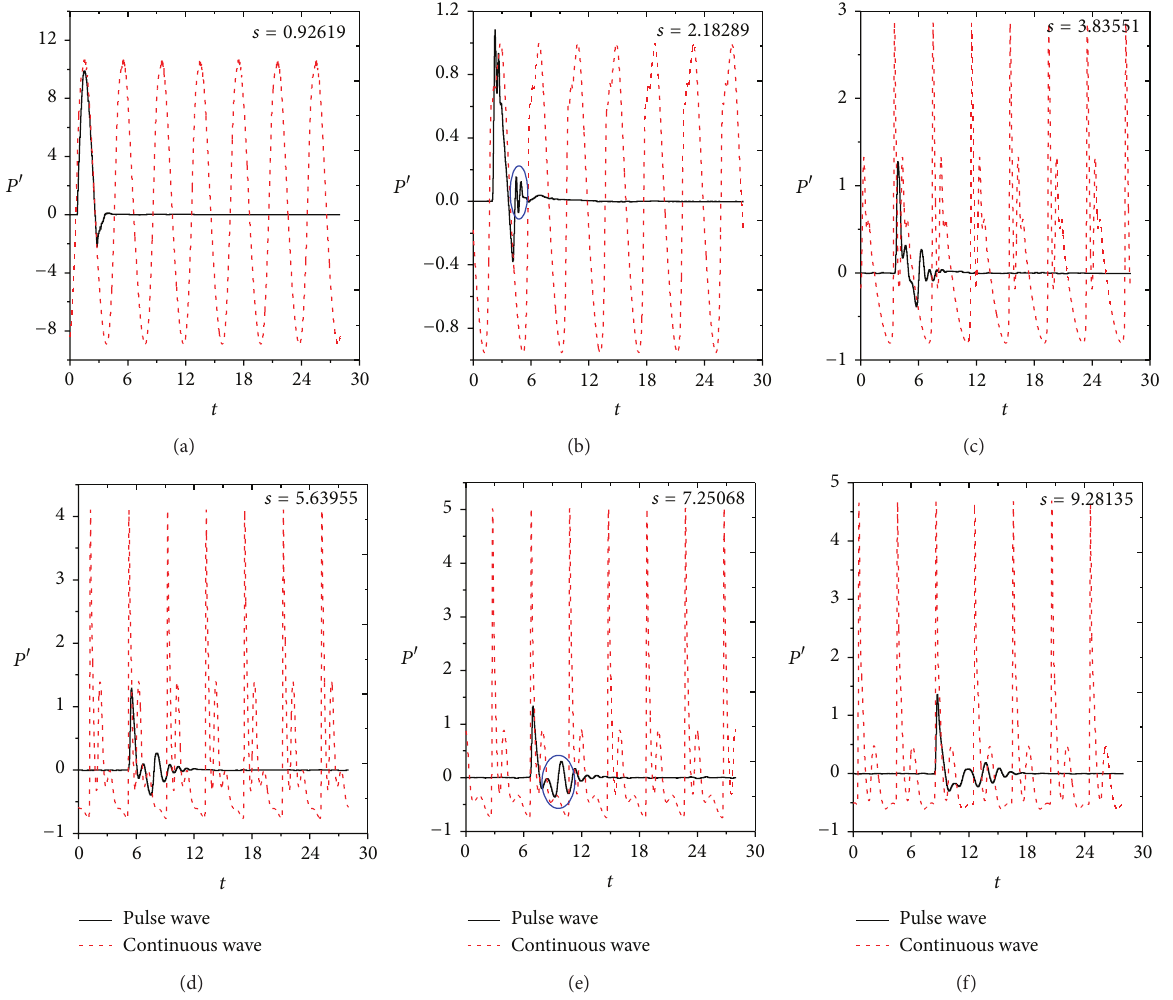
Figure 7: Pressure disturbance at different surface locations varying with